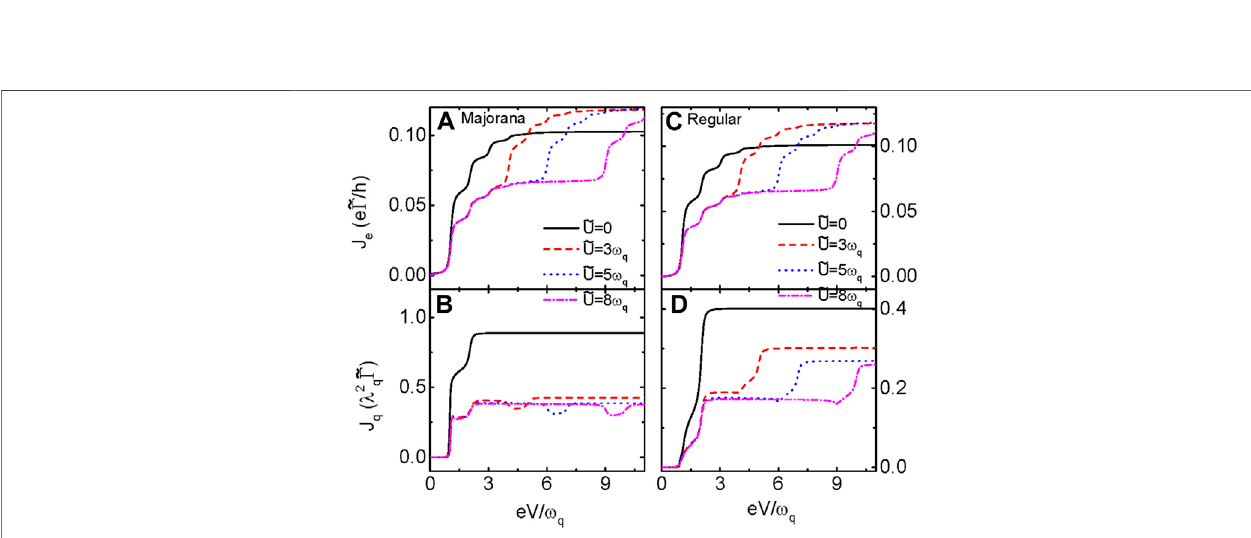
Frontiers in Physics |